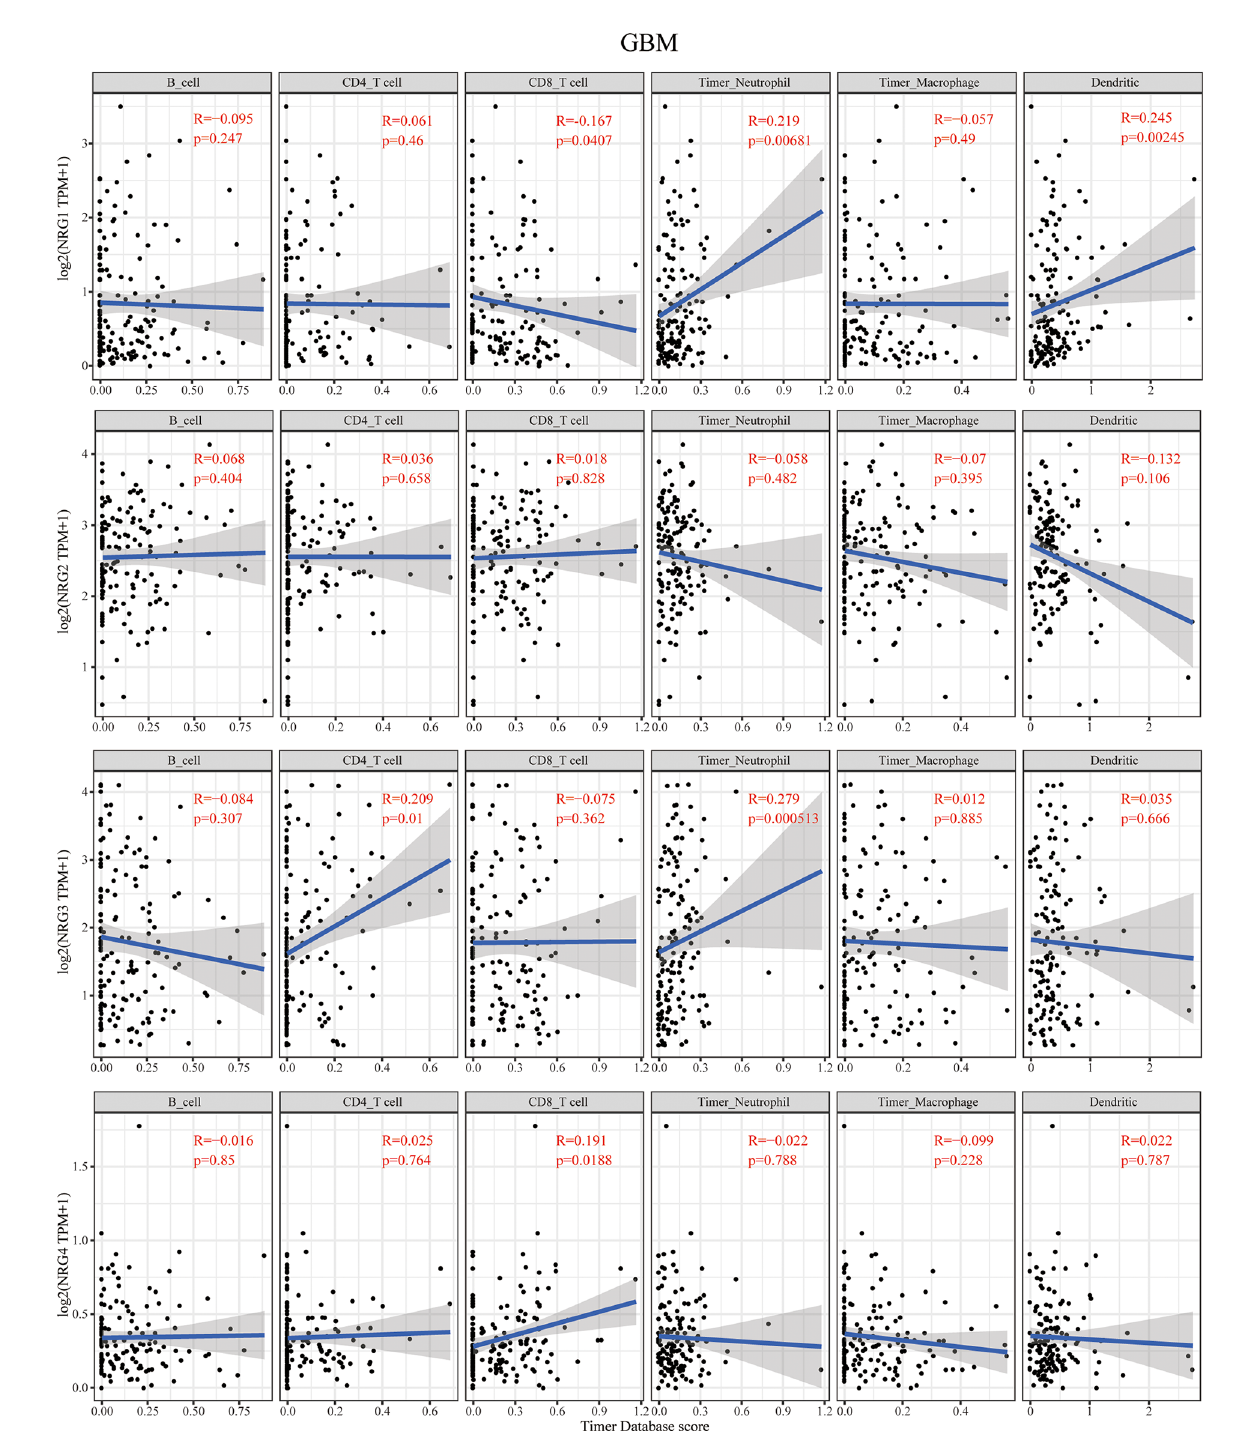
FIGURE 4 | Correlations between NRGs expression and immune cell in fi ltration in GBM. Correlations between the abundance of 6 immune cells (B cell, CD4+ T cell, CD8+ T cell, neutrophils, macrophage and dendritic cell) from the TIMER database and the expression of NRG1-4 in GBM. Spearman ’ s correlation analysis was used to describe the correlation. P < 0.05 was considered statistically signi fi